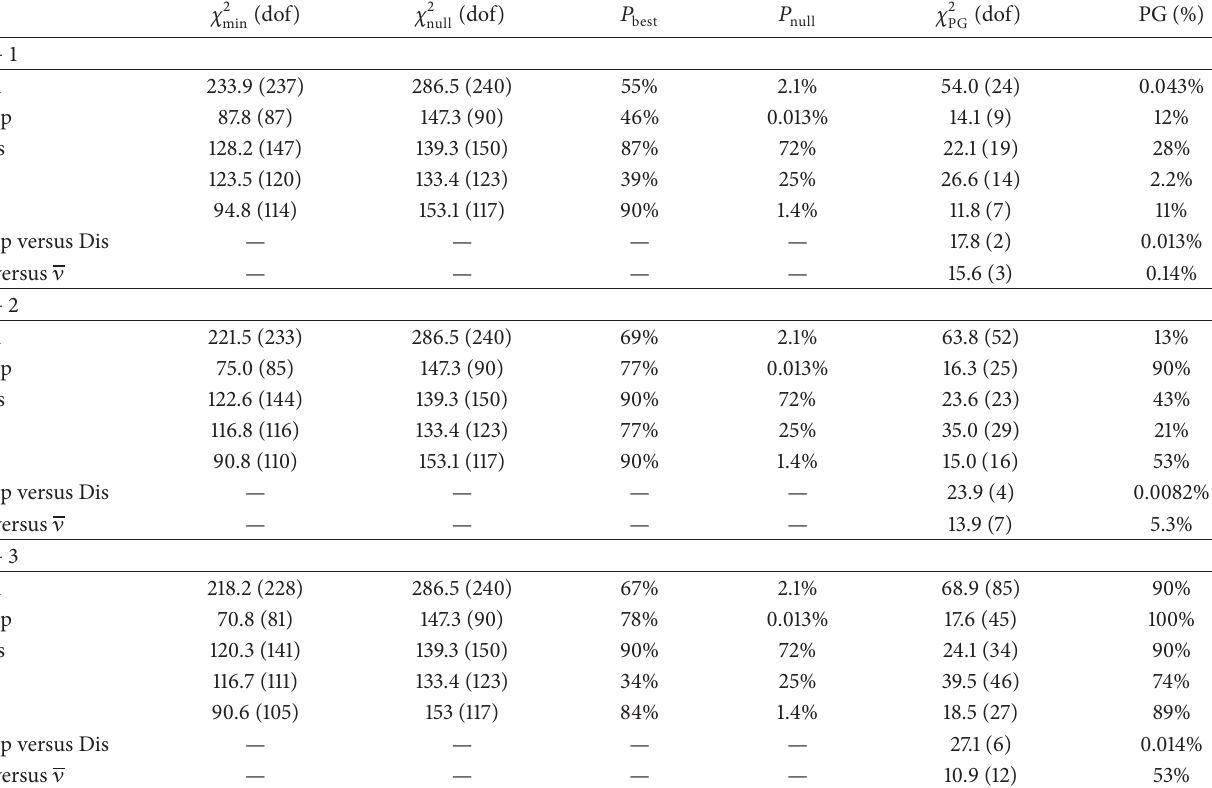
Table 2: The 𝜒 2 values, degrees of freedom (dof), and probabilities associated with the best-fit and null hypothesis in each scenario. Also shown are the results from the parameter goodness-of-fit tests. 𝑃 𝜒 2 -probability at